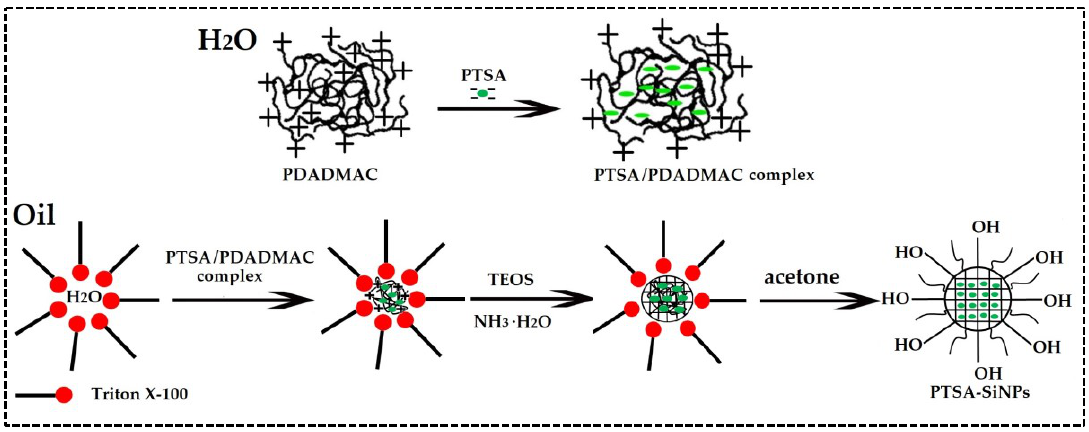
Figure 1. The preparation mechanism diagram of PTSA-SiNPs.